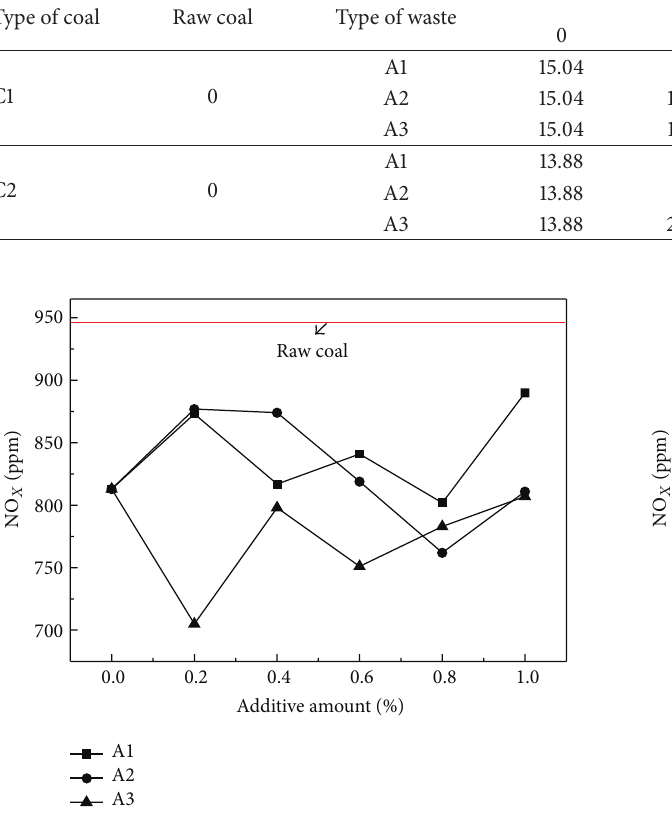
release concentration of SO 2 . From the overall trend, A + A1 showed the best effect on reducing the release of SO 2